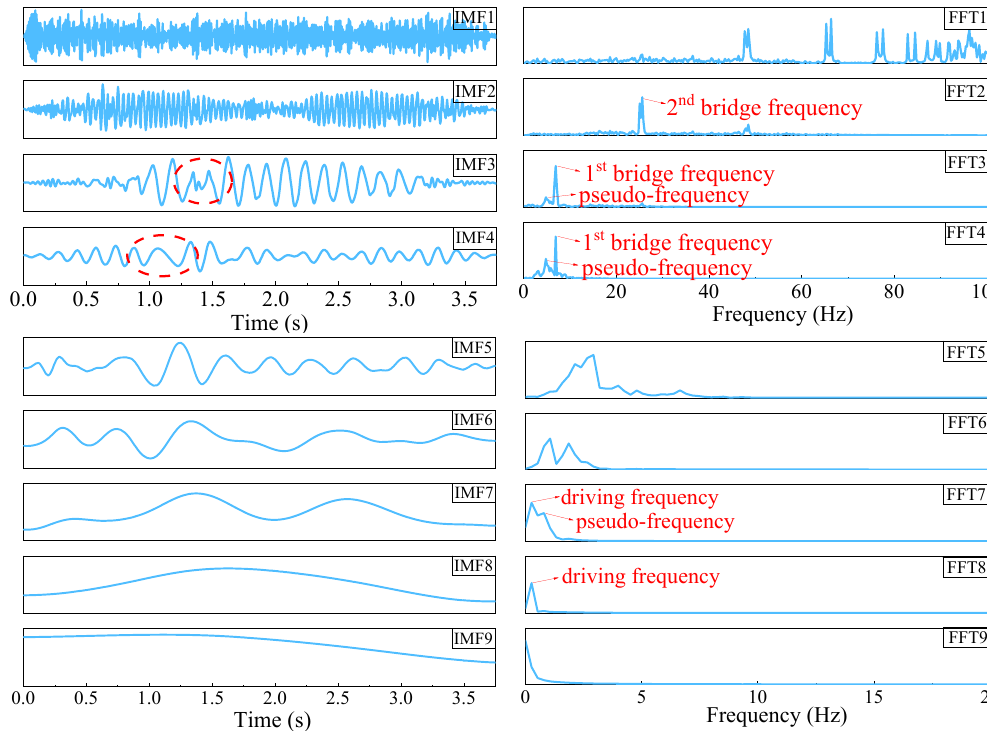
Figure 7. The IMF and FFT of the WC extracted by EEMD.